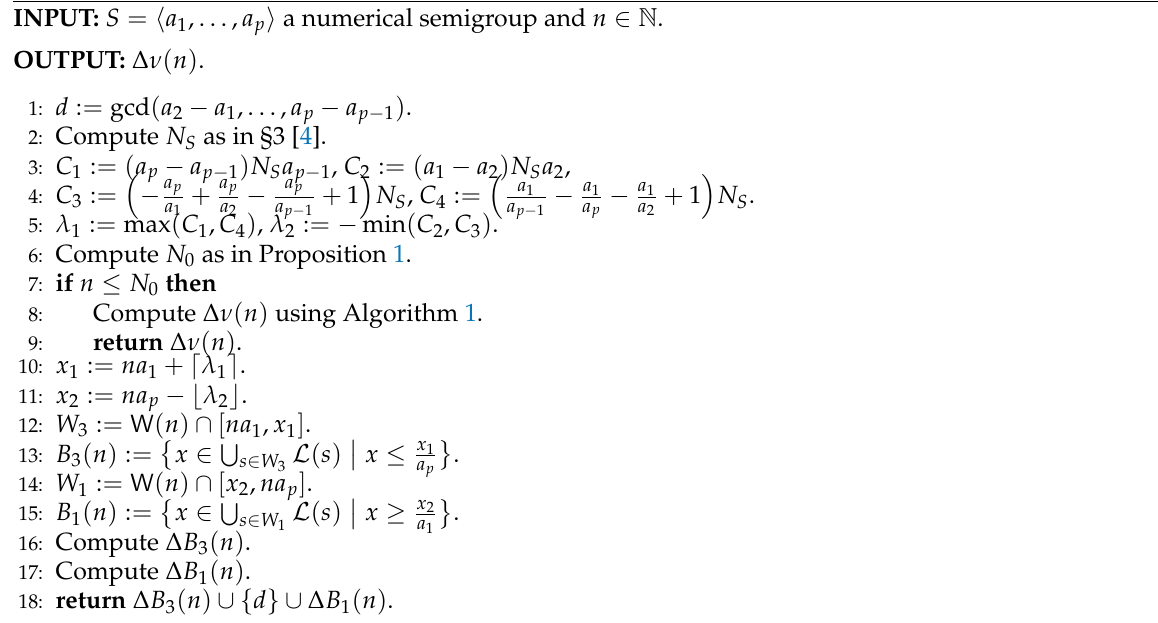
Algorithm 2 Sketch of the algorithm to compute ∆ ν ( n )